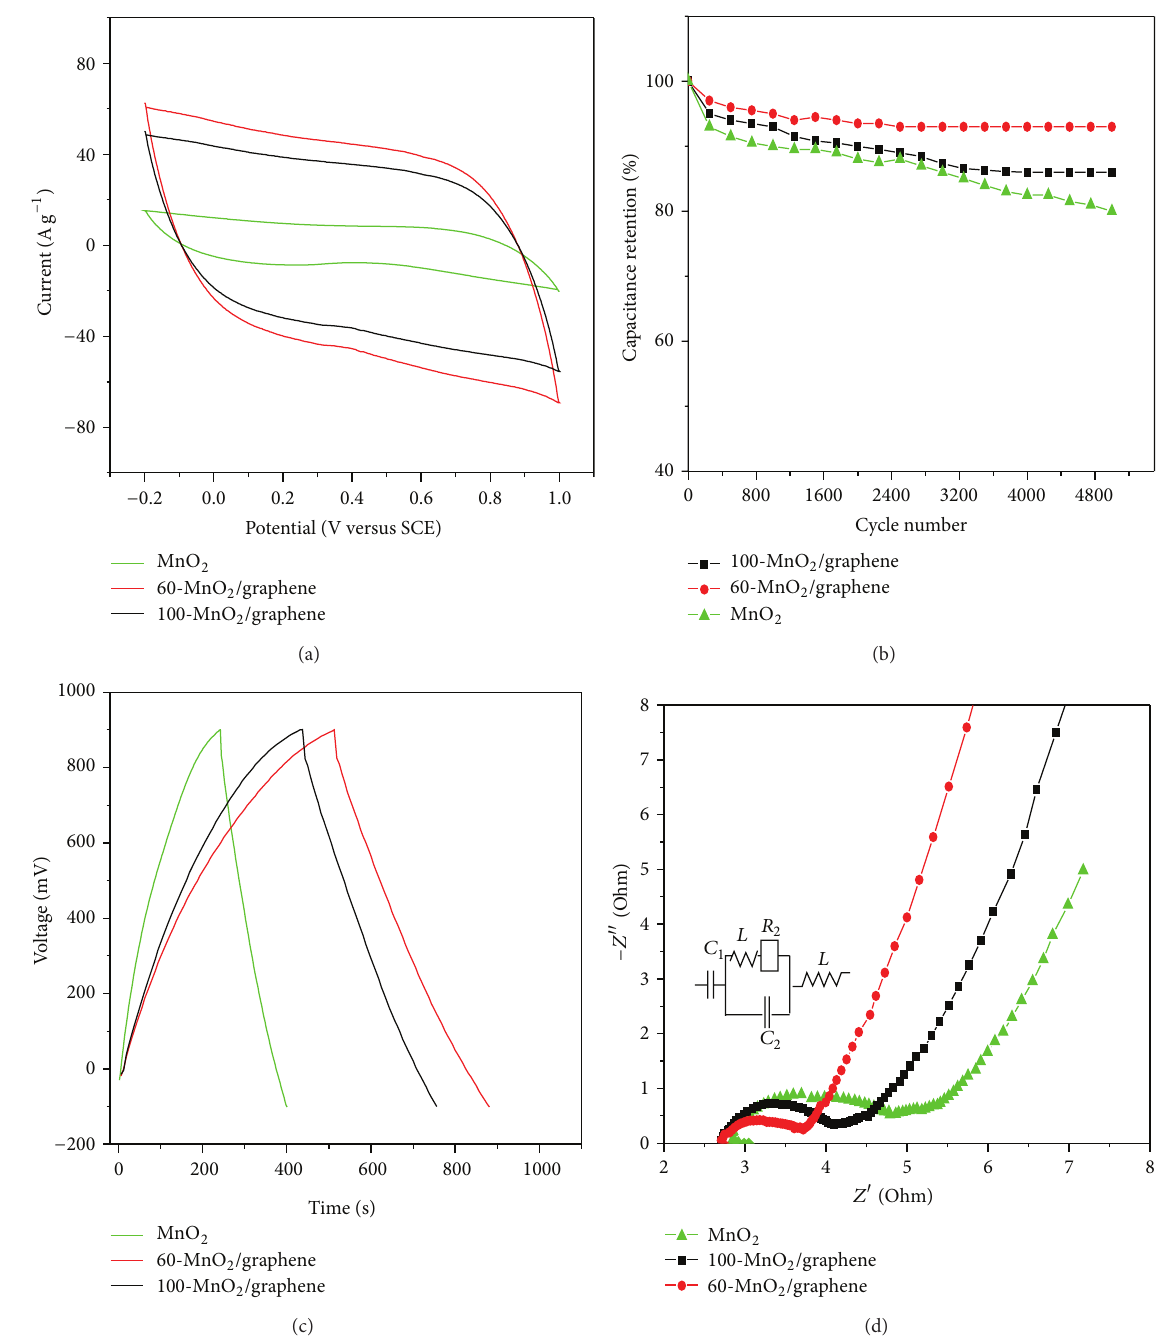
Figure 8: (a) CV curves at 50mV/s. (b) Cycle number at 1A/g. (c) Galvanostatic charge/discharge curves at 1A/g. (d) Nyquist plots of electrodes; inset is the electrical equivalent circuit used for fitting impedance